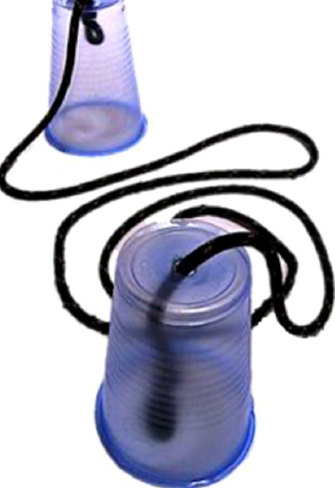
FIG. 5. Homemade lovers ’ telephone demonstrated during the